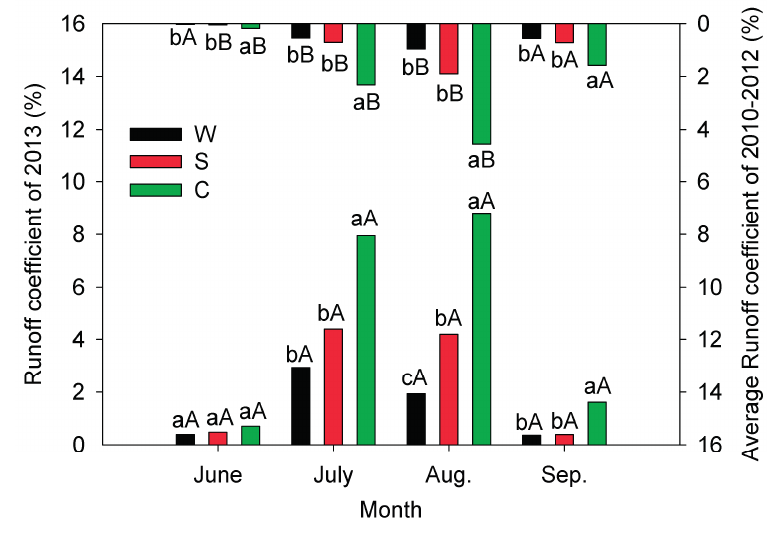
Figure 6. Monthly runoff coefficients in the “extreme year” and “normal year”. The capital and lower-case letters represent the significance of the difference ( p < 0.05) as those in Figure